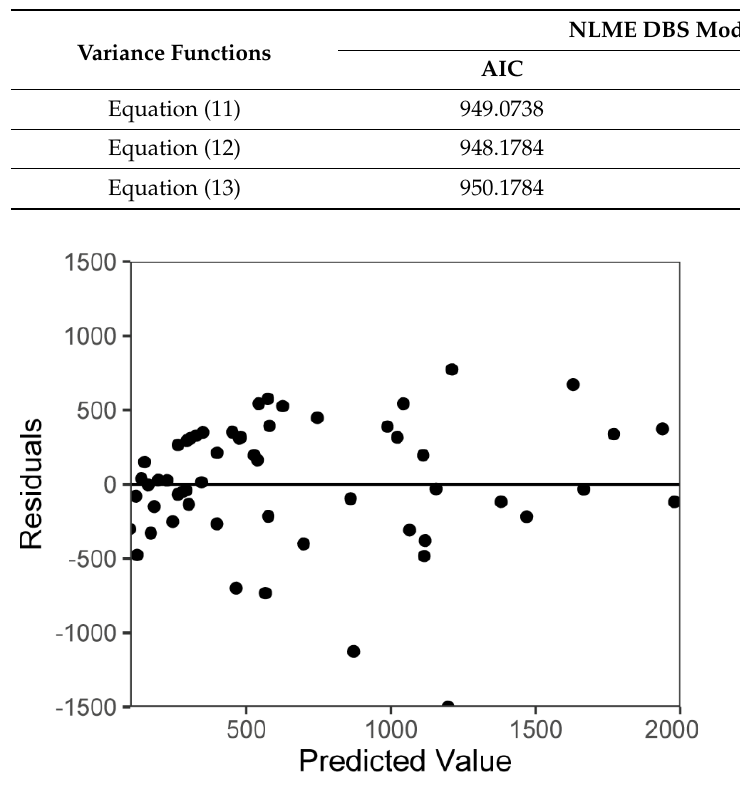
Table 6. Comparisons among three variance functions (exponential function, power function, and constant plus power function) of the NLME DBS model (LL, log-likelihood).